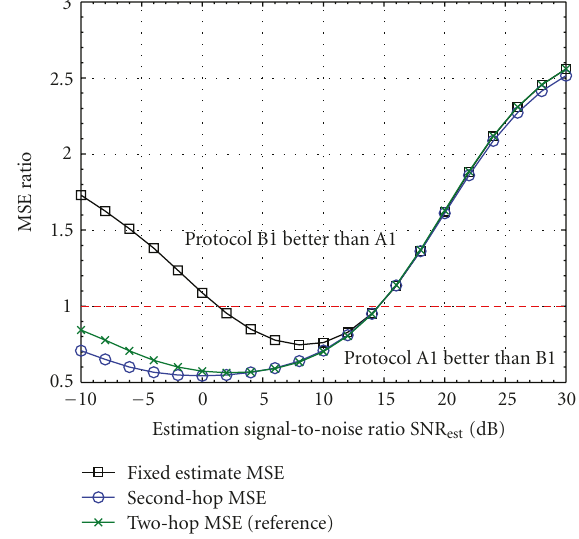
Figure 7: MSE ratios (see page 23) versus SNR est for N R = 10, τ = 1, = 10 − 2 and σ 2 pn